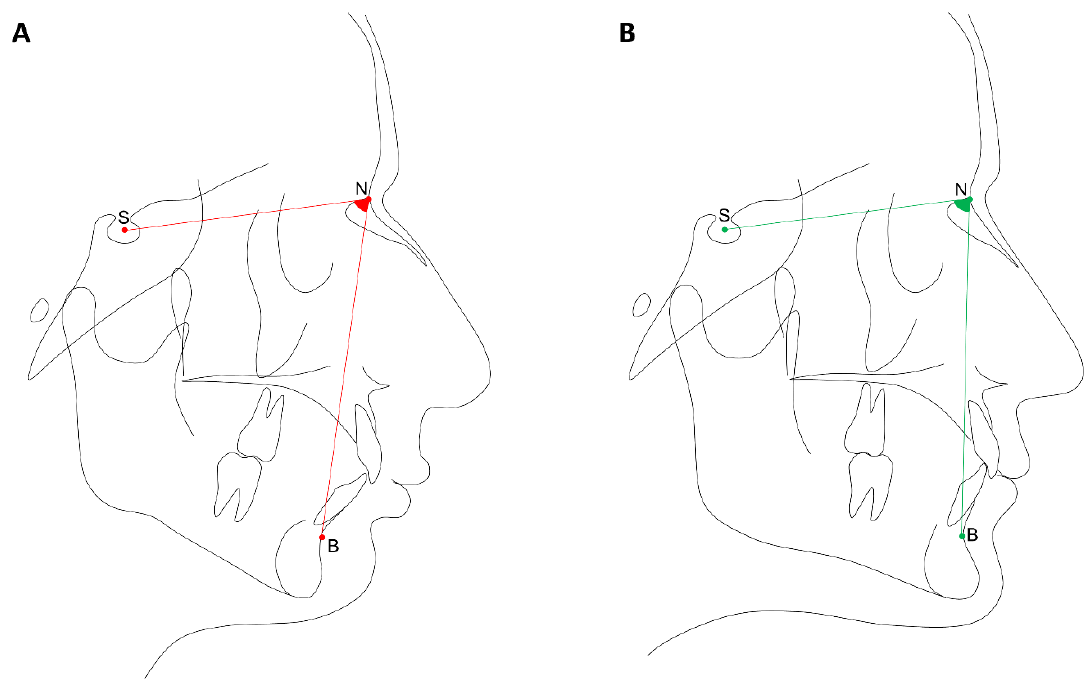
Figure 1. Cephalometric tracings. ( A ) Exemplification of retrognathism (SNB > 78°). ( B ) Exemplification of orthognathic mandible (SNB ranging from 78° to 82°).